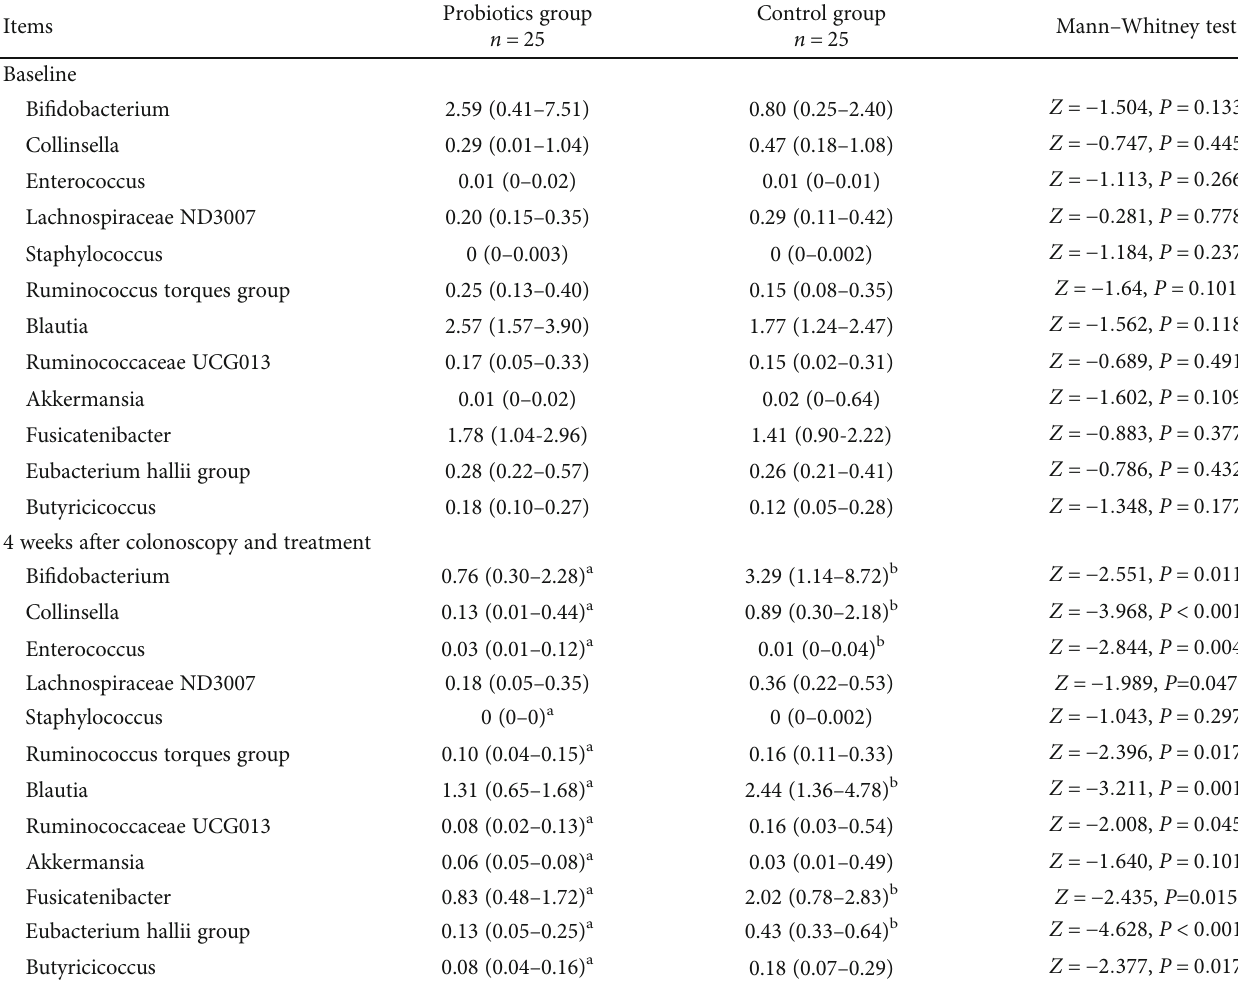
Table 3: Composition of the gut microbiota at the genus level (median (IQR),